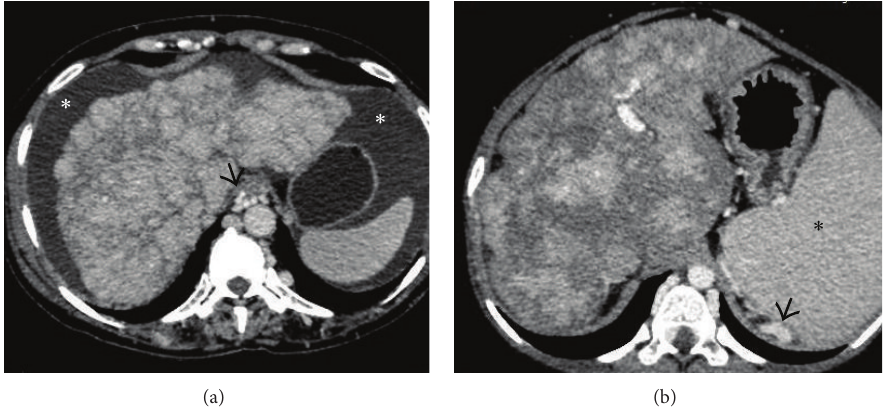
Figure 8: Axial images from the CECT scan of two different patients with chronic BCS demonstrating cirrhotic architecture of liver in the form of irregular lobulated outlines and heterogeneous mottled hepatic parenchymal enhancement. Ascites (asterisks in (a)), splenomegaly (asterisk in (b)) and paraesophageal and perisplenic collaterals (arrow in (a) and (b), resp.) can also be